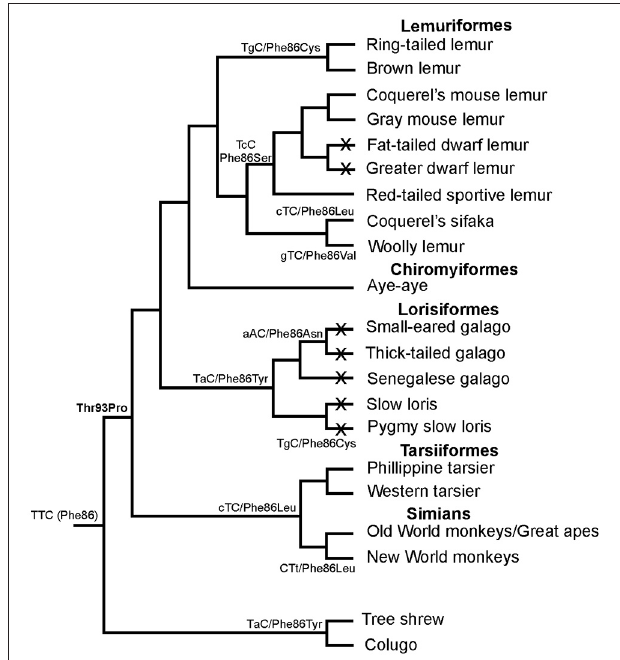
FIGURE 3 | Phylogenetic relationships of different primate species showing the different residues found at site 86 in S cone opsins, together with the corresponding codon sequences. Under the scenario presented, Phe86 was present in the ancestral primate and retained by the aye-aye. Replacement of Phe by either Leu, Cys, Asn, Val, Ser, or Cys then occurred by single nucleotide changes at each step to generate the amino acid changes. Crosses on lineages indicate species where SWS1 pseudogenes are present. Based on data from Carvalho et al. (2012).